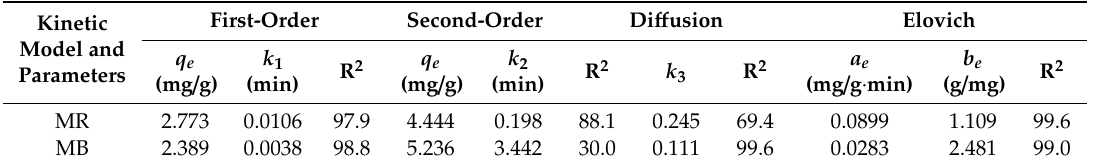
Table 2. Adsorption kinetic parameters of MB and MR on the cGO–PAN composite nanofiber membranes obtained from graphs in Figure 7.